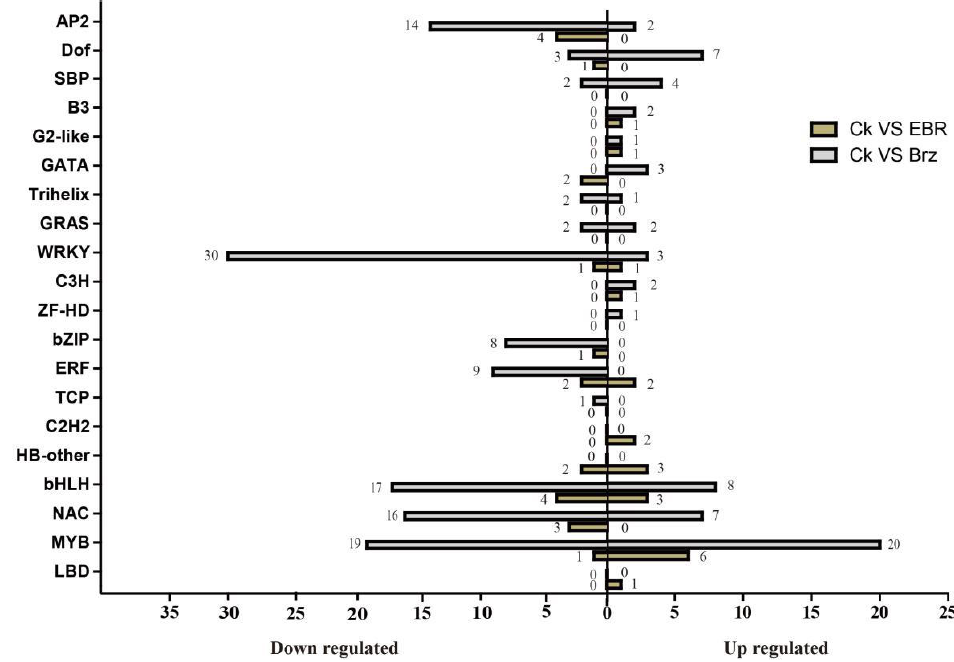
Figure 7. Identification of BR signal-responsive TFs.